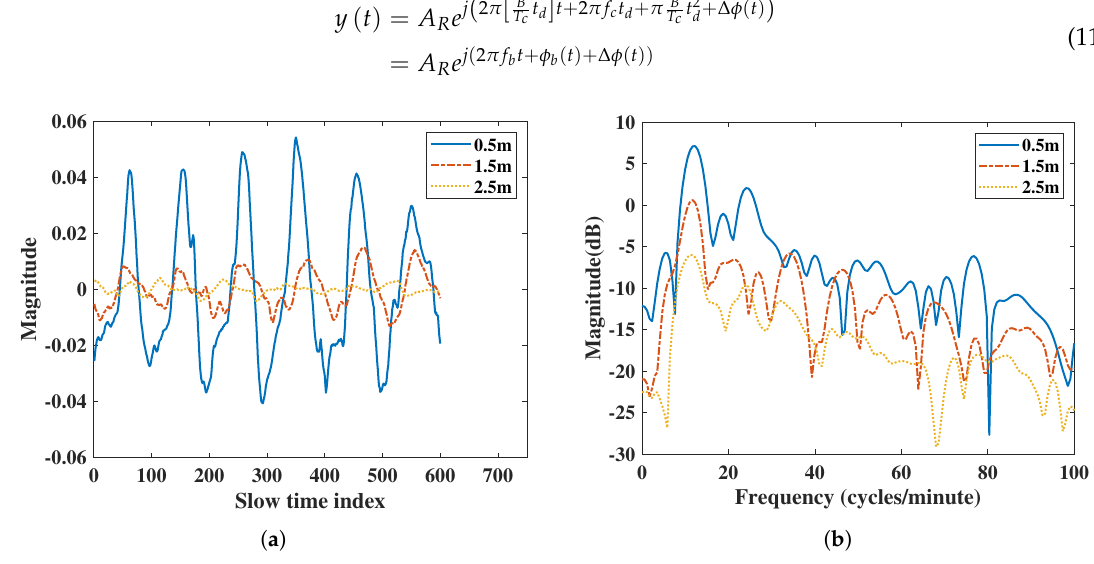
Figure 2. Vital signs extracted using IR-UWB radar at 0.5 m, 1.5 m, and 2.5 m: ( a ) vital signs extracted by IR-UWB radar in the time domain, ( b ) vital signs extracted by IR-UWB radar in the frequency